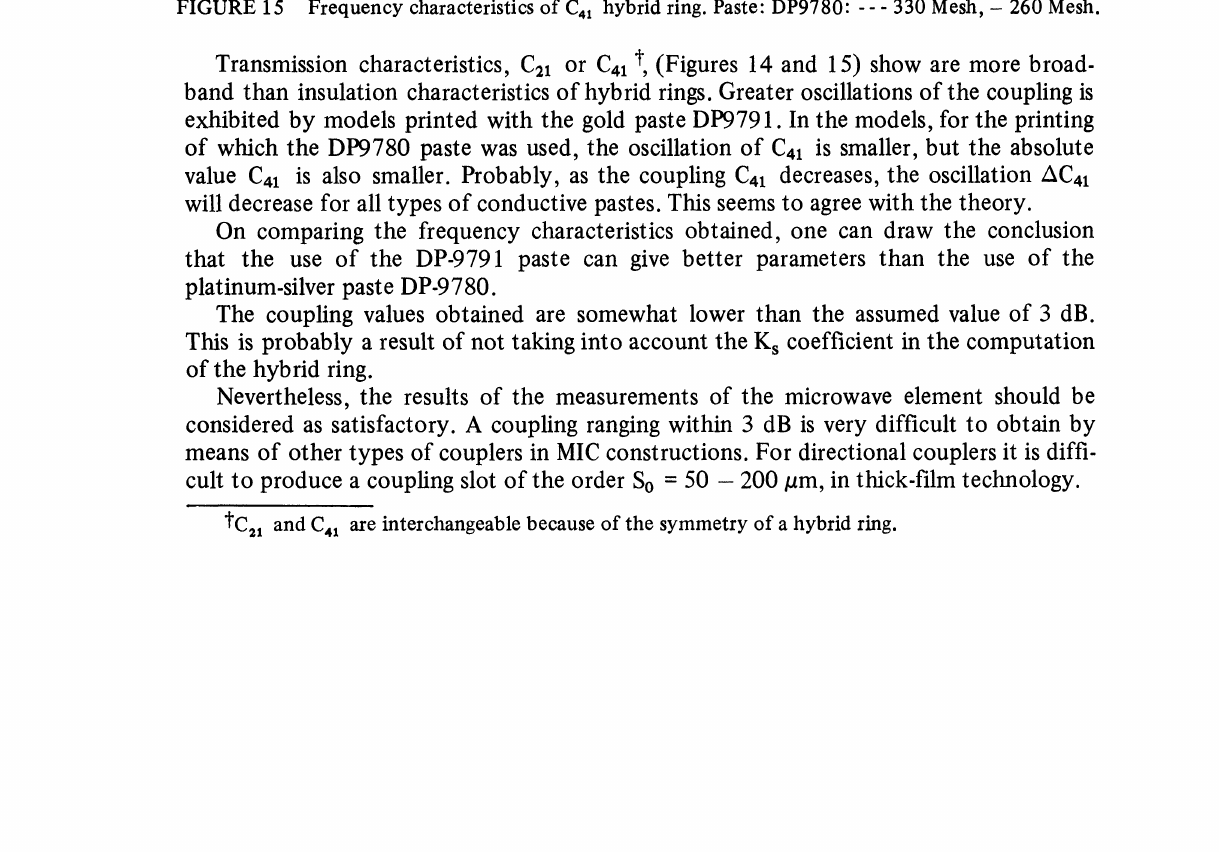
FIGURE 14 Frequency characteristics of C41 hybrid ring. Paste: DP9791 330 Mesh; 260 Mesh.